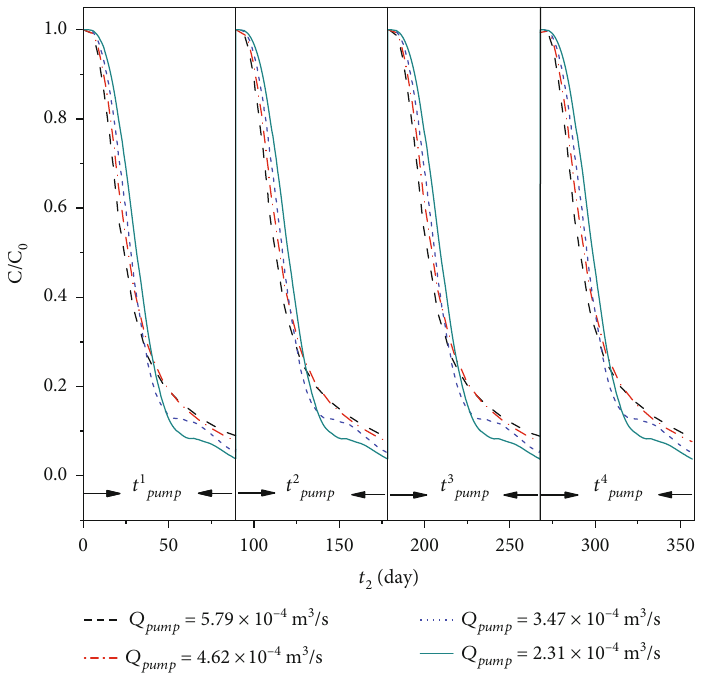
Figure 10: BTCs inside the well with di ff erent pumping rates during the pumping phase. (a) Q pump = − 2 : 31 × 10 − 4 m 3 /s; (b) Q pump = − 3 : 47 × 10 − 4 m 3 /s; (c) Q = − 4 : 62 × 10 − 4 m 3 /s; (d) v = Q = − 5 : 79 × 10 − 4 m 3 /s. pump d pump